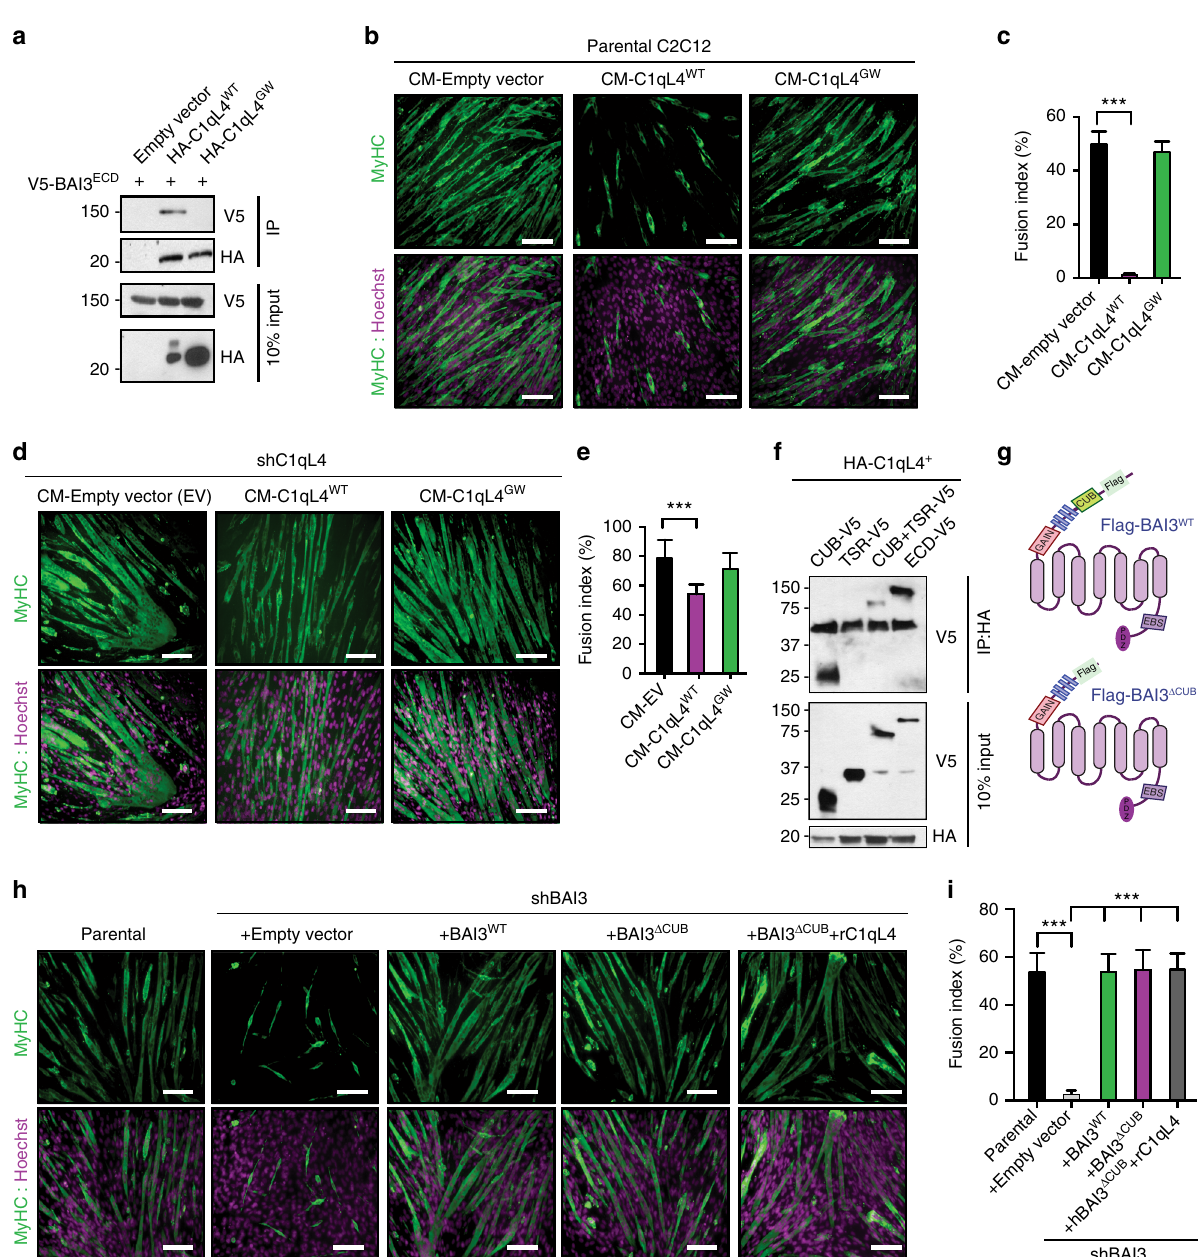
Fig. 3 C1qL4 acts as a BAI3 ligand to negatively control myoblast fusion. a Generation of a C1qL4 mutant (C1qL4 GW ) unable to bind BAI3. Anti-HA immunoprecipitations (IP) of HA-C1qL4 WT or HA-C1qL4 GW was carried out to assess the interaction with V5-BAI3 ECD . The HA-C1qL4 GW mutant is defective to interact with V5-BAI3 ECD . b Treatment of C2C12 cells with C1qL4 WT -conditioned media (CM) blocks myoblast fusion. C1qL4 GW -conditioned media had no effect on myoblast fusion. c Quanti fi cation of experiments shown in b . d C2C12 cells expressing shC1ql4 display normal myoblast fusion when treated with HA-C1qL4 WT -conditioned media. HA-C1qL4 GW was unable to revert the increased fusion following C1qL4 depletion. e Quanti fi cation of experiments shown in d . f The CUB domain of BAI3 is the minimal region necessary for interaction with C1qL4. Immunoprecipitations of HA-C1qL4 were carried out to assess which part of the BAI3 extracellular domains is responsible for the interaction with the ligand. g Schematic representation of Flag- BAI3 WT and mutant (Flag-BAI3 Δ CUB ) where the CUB domain was deleted. h The CUB domain is dispensable for myoblast fusion. Expression of either BAI3 WT or BAI3 Δ CUB restores fusion in C2C12 cells depleted of endogenous BAI3 by shRNA. i Quanti fi cation of experiments shown in h . Myo fi bers were stained for Myosin Heavy Chain (MyHC, MF20 antibody (green)) and nuclei were revealed by Hoechst (purple). Error bars indicate standard deviation. Scale bar = 100 μ m. One-way ANOVA followed by a Bonferroni test was used to calculate the P- values; *** P <